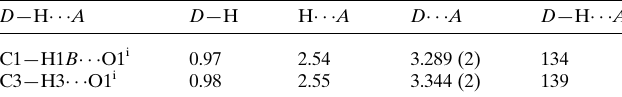
Table 1 Hydrogen-bond geometry (A˚ , (cid:3) ).